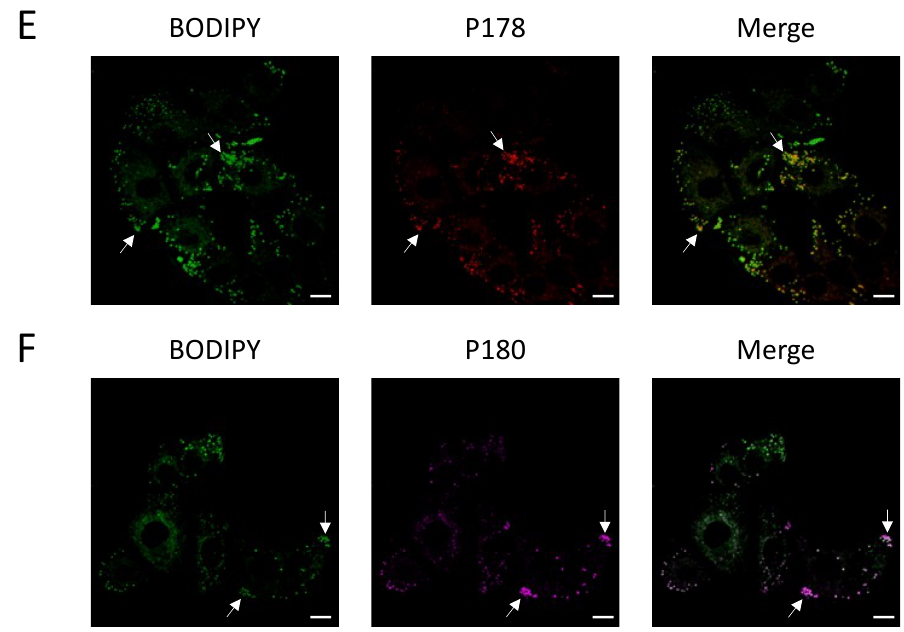
Figure 4. GS-1 localizes to lipid droplets. (A) Confocal time course microscopy analysis of A549 cells stained with BODIPY and treated with GS-1 (scale bar = 10 µm; images representative of 3 experiments). (B) A549 cells were stained with BODIPY and treated with GS-1 prior to analysis by flow cytometry to determine lipid droplet levels as indicated by BODIPY MFI (n=3, ± S.E.M.). (C) Confocal time course microscopy analysis of Jurkat cells stained with BODIPY and treated with GS 1 (scale bar 50 µm; images representative of 3 experiments). (D) Jurkat cells were stained with BODIPY and treated with GS-1 prior to analysis by flow cytometry to determine lipid droplet levels as indicated by BODIPY MFI (n=3, ± S.E.M.). A549 cells were stained with BODIPY and either (E) Dye 1 or (F) Dye 2 for 4 h prior to confocal microscopy to determine GS-1